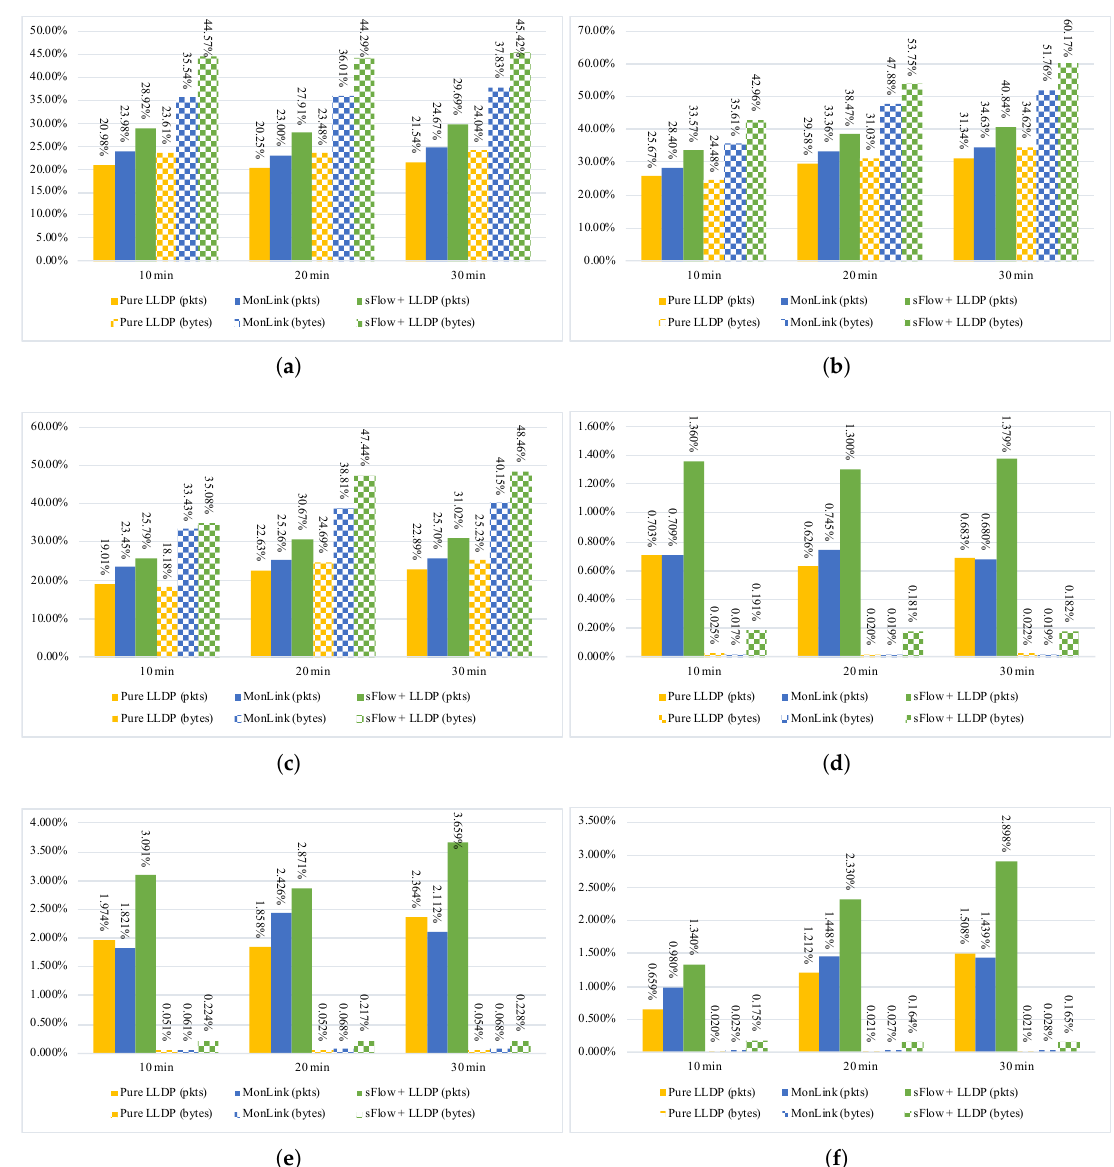
Figure 7. Traffic overhead comparison: MonLink v.s. sFlow. ( a ) Traffic overhead under ring topology without user traffic. ( b ) Traffic overhead under mesh topology without user traffic. ( c ) Traffic overhead under fat-tree topology without user traffic. ( d ) Traffic overhead under ring topology with video traffic. ( e ) Traffic overhead under mesh topology with video traffic. ( f ) Traffic overhead under fat-tree topology with video